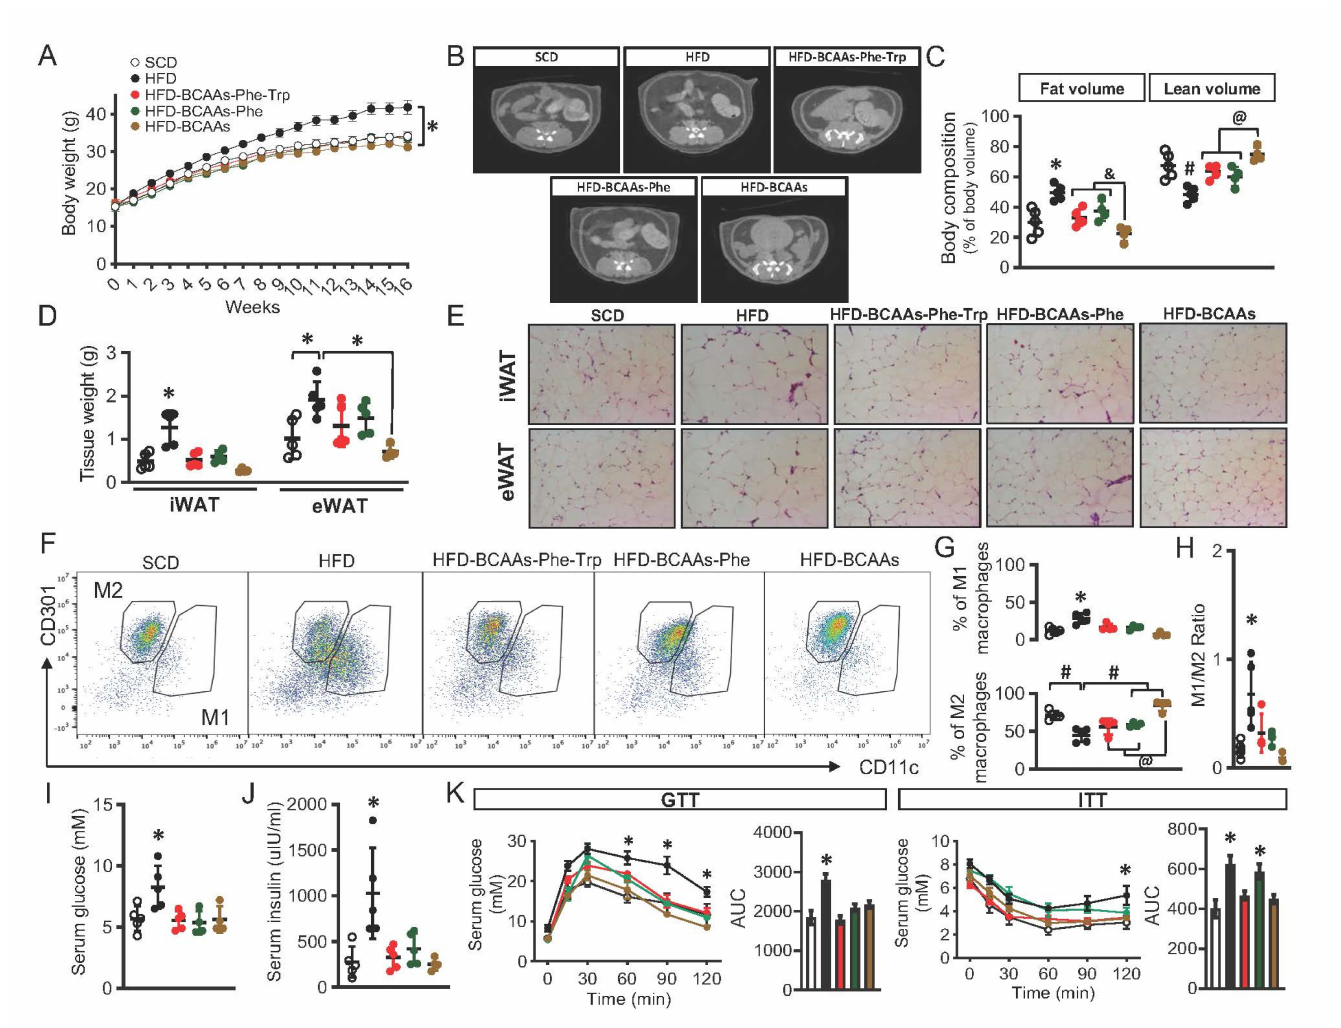
Figure 4. Metabolic regulation with restriction of BCAAs, phenylalanine and tryptophan. C57BL/6J mice (4 weeks) were fed by high-fat diet (HFD) with or without combinations of restrictions in branched-chain amino acids (BCAAs), phenylalanine and tryptophan for 16 weeks. Body weight was monitored weekly ( A ) and body composition was detected by a micro CT scanning at the end of experiment in ( B , C ). Adipose tissue weight ( D ) and Hematoxylin and Eosin (H&E) staining ( E ) were performed to further evaluate any alterations in adipose tissue. M1 and M2 macrophages ( F – H ) in isolated stromal vascular fraction (SVF) were quantified by a flow-cytometer. Fasting blood glucose and serum insulin levels were detected ( I , J ) and insulin resistance in these mice were measured by intraperitoneal glucose tolerance test (GTT) and insulin tolerance test (ITT) ( K ). All data are presented as mean ± standard deviation (SD). * p ≤ 0.05 increase vs. all other groups in (( A , C , D ) left), ( G ) to ( K ) or vs. the groups of SCD and HFD-BCAAs in (( D ) right). & p ≤ 0.05 reduction vs. both groups of HFD-BCAAs-Phe-Trp and HFD-BCAAs-Phe in ( C ). # p ≤ 0.05 reduction vs. all other groups or vs. the groups of SCD, HFD-BCAAs-Phe and HFD-BCAAs in ( C , G ). @ p ≤ 0.05 increase vs. the groups of HFD-BCAAs-Phe-Trp and HFD-BCAAs-Phe in ( C , G ). iWAT-inguinal subcutaneous white adipose tissue. eWAT- epidydimal white adipose tissue. BCAA: branched-chain amino acids; SCD: standard chow diet; HFD: high-fat diet; HFD-BCAA: high-fat diet with 2/3 reduction of branched-chain amino acids; HFD-BCAAs-Phe: high-fat diet with 2/3 reduction of branched-chain amino acids and phenylalanine; HFD-BCAAs-Phe-Trp: high-fat diet with 2/3 reduction of branched-chain amino acids, phenylalanine, and tryptophan. Color codes indicated on ( A ) are the same as for ( C , D , G – K